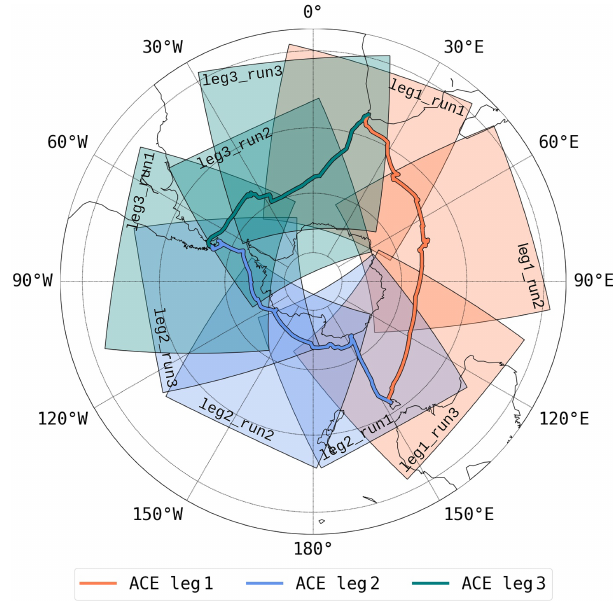
Figure 2. Domains of the nine COSMO iso simulations (see also Table 1). The ACE ship track is indicated by a bold line, coloured differently for the three legs of the